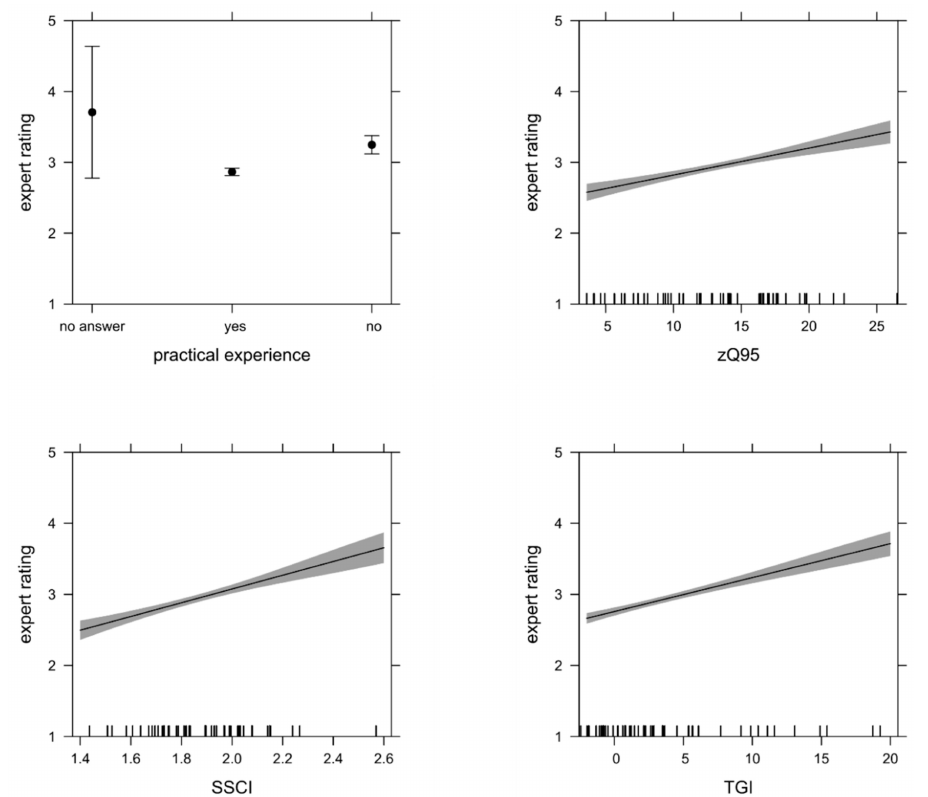
Figure 6. E ff ect plots of the statistically significant predictors. Grey areas and whiskers indicate 95% confidence intervals. The scale from the expert rating goes from 1 very low up to 5 very high structural richness. Upper left: e ff ect of practical experience in the assignment of habitat trees, top right: e ff ect of the 95% height quantile from the TLS data, lower left: e ff ect of the stand structural complexity index (SSCI), lower right: e ff ect of the triangular greenness index